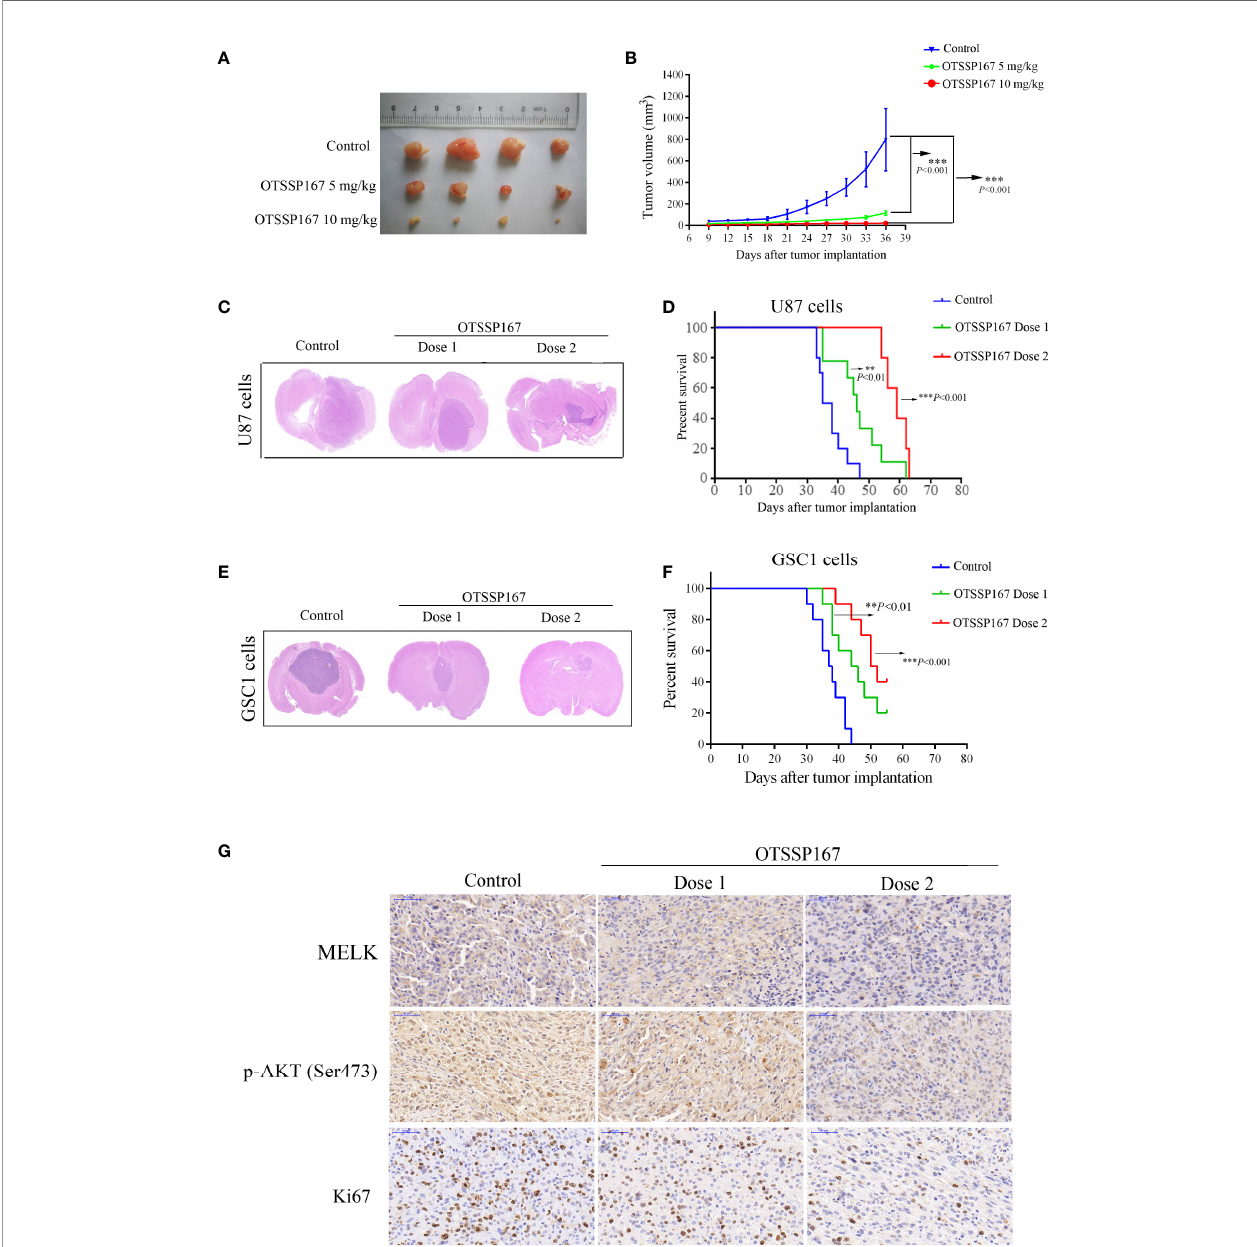
FIGURE 6 | OTSSP167 suppresses tumor growth in vivo and increases the survival of animals bearing intracranial GBM. (A) Representative tumors isolated from the control and OTSSP167-treated groups of subcutaneous tumor model. (B) The mean tumor volumes were assessed at the indicated numbers of days after tumor implantation. (C) Mice bearing U87 xenograft tumor were treated with OTSSP167 (5 m L of 1 m M (dose 1) or 2 m M (dose 2) OTSSP167 in 1% DMSO in PBS per mouse) or vehicle control by intratumoral injection once a week for 4 weeks. Representative images of H&E staining of whole brain sections from control group and OTSSP167 treatment group. (D) Kaplan-Meier survival curves of mice implanted with U87 cells (n=10, ** P < 0.01, *** P < 0.001). In vivo animal studies to investigate the effect of OTSSP167 administration on the growth of GSC-driven tumor. Tumor size (E) and survival time (F) were analyzed by using the above same treatment. The survival time of tumor-bearing mice was counted by the end of the 55th day after tumor implantation. (G) Representative IHC staining images of p-AKT(Ser473) and Ki67 expression in U87 xenograft tumor of control and OTSSP167 treatment groups. Sections were counterstained with